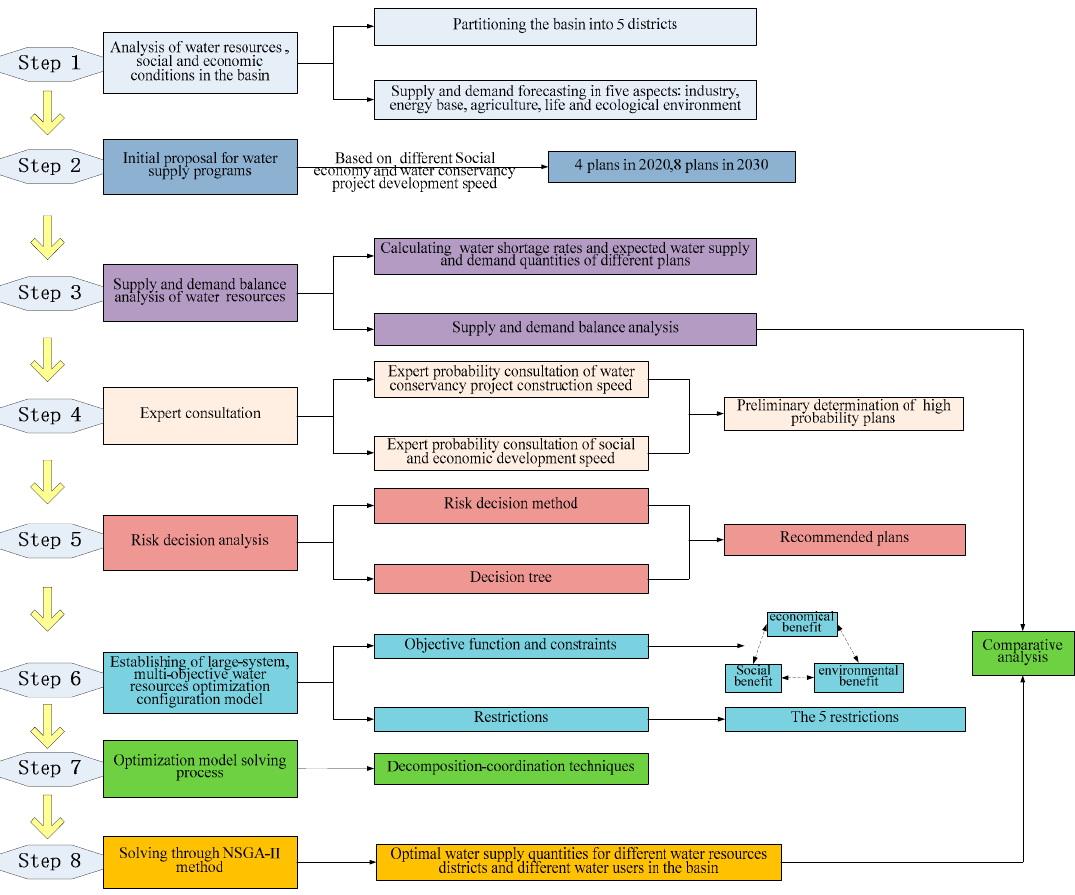
Figure 2. Research steps and framework.